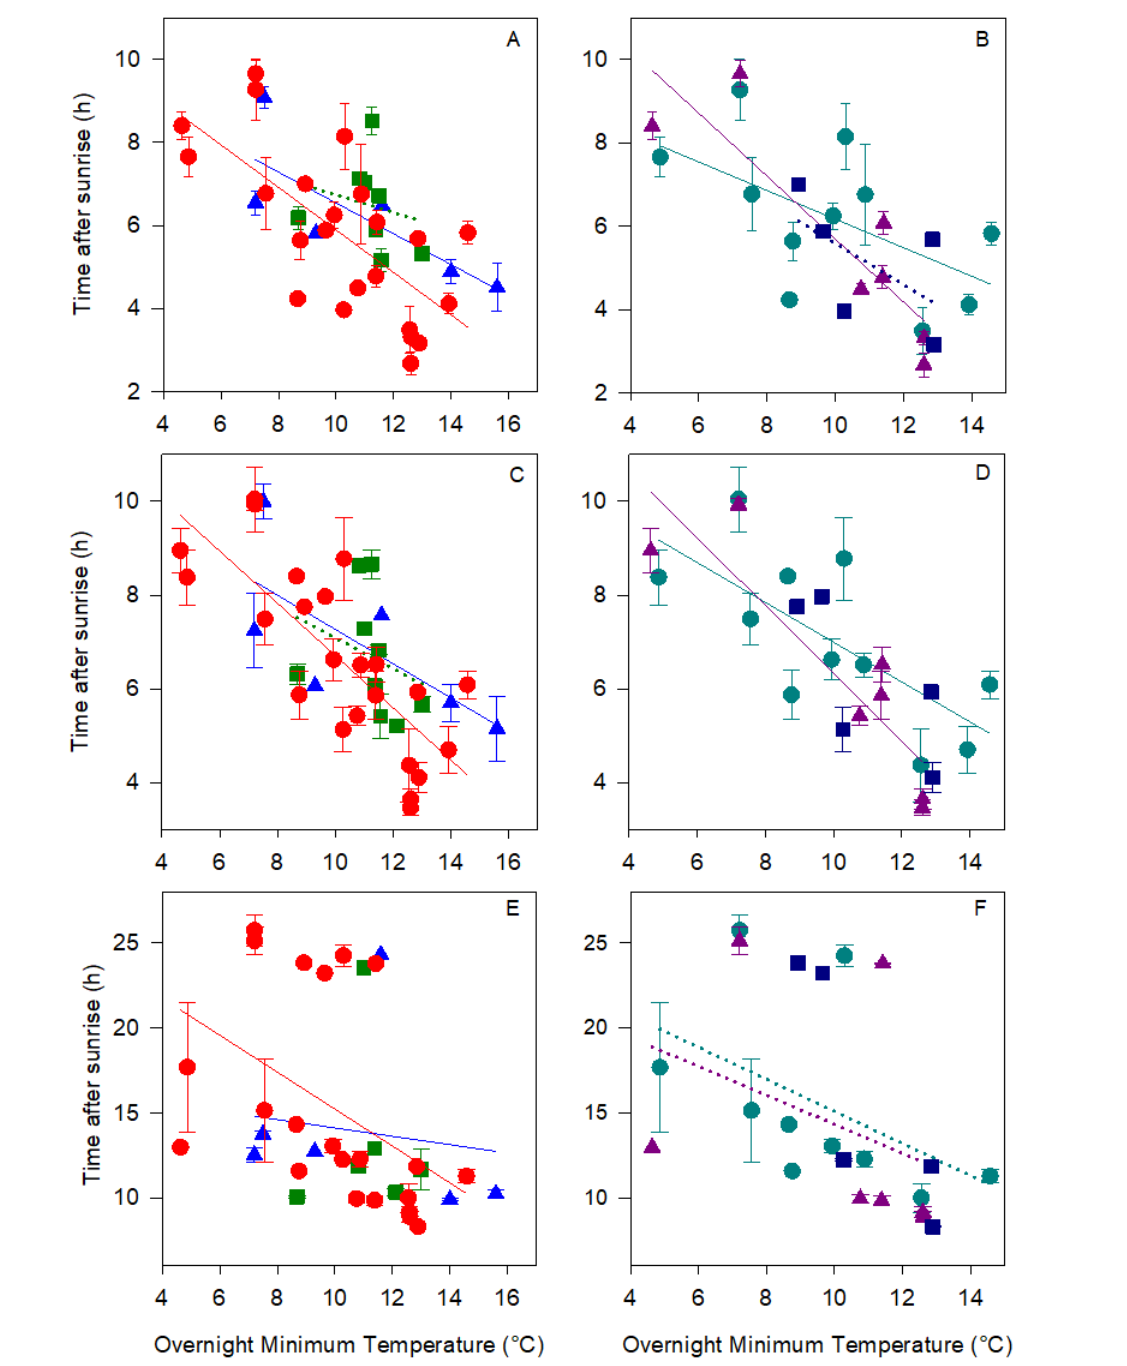
F IGURE 2: The relationship between overnight minimum temperatures and the time to avocado flowering Stages 1 (A), 2 (C) and 5 (E) for 2011, 2012 and 2013, and the time to Stages 1 (B), 2 (D) and 5 (F) in regards to the location of the flowers on the tree (2013 only). Datapoints show times averaged by day of observations (mean +/- SEM). Sunset occurred between 13-16 hours after sunrise during this study. The cluster of points between 23-26 hours in Fig. 2E & 2F indicate flowers closing at or after dawn the following day. Significant correlations (P < 0.006) are indicated by solid lines; dotted lines indicate correlations that had P-values between 0.05 –